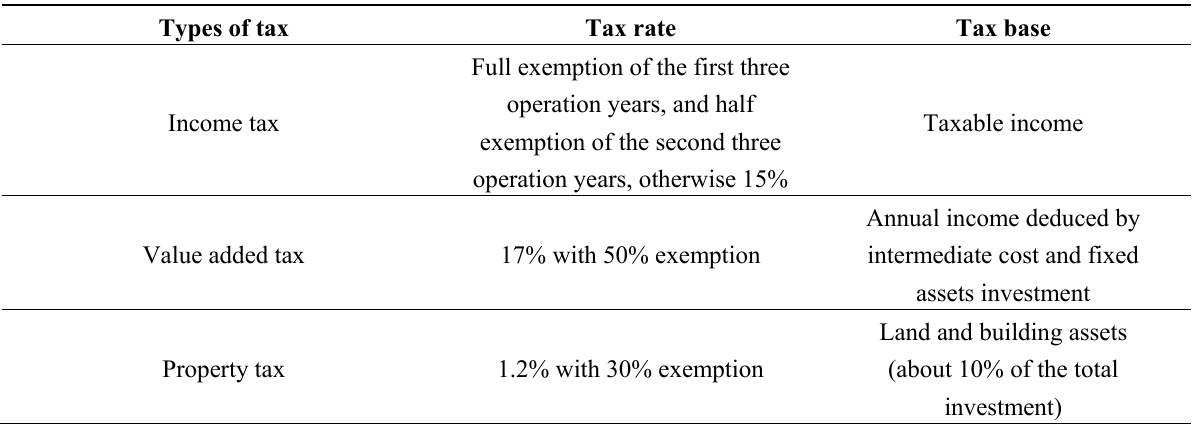
Table 5. Tax and policy